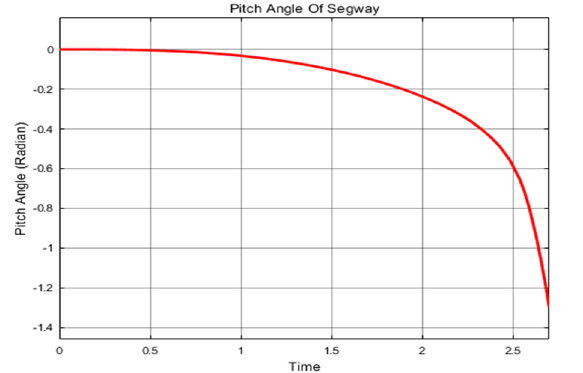
Fig. 7: Step Response of the Segway Pitch Angle